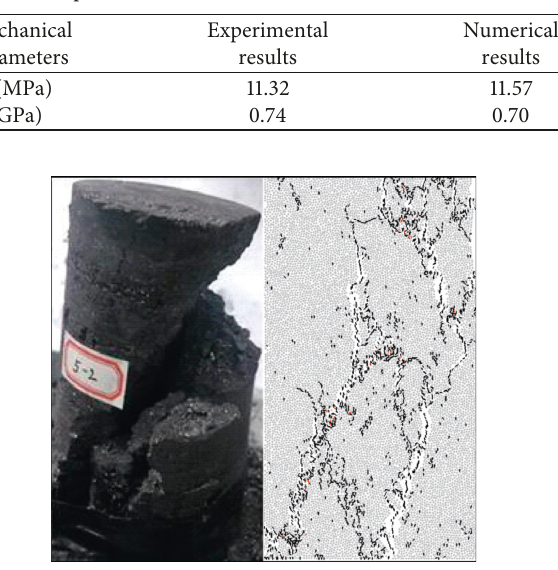
Figure 4: Comparison between experimental and numerical failure modes of coal under uniaxial compression test. The black and red dots represent the tensile microcrack and shear microcrack, respectively.